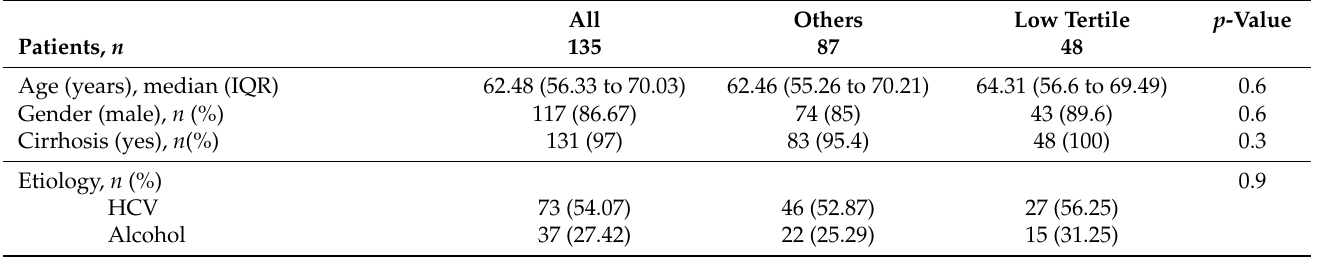
Table 6. Comparison of baseline and clinical variables between low tercile vs. high and mid terciles.